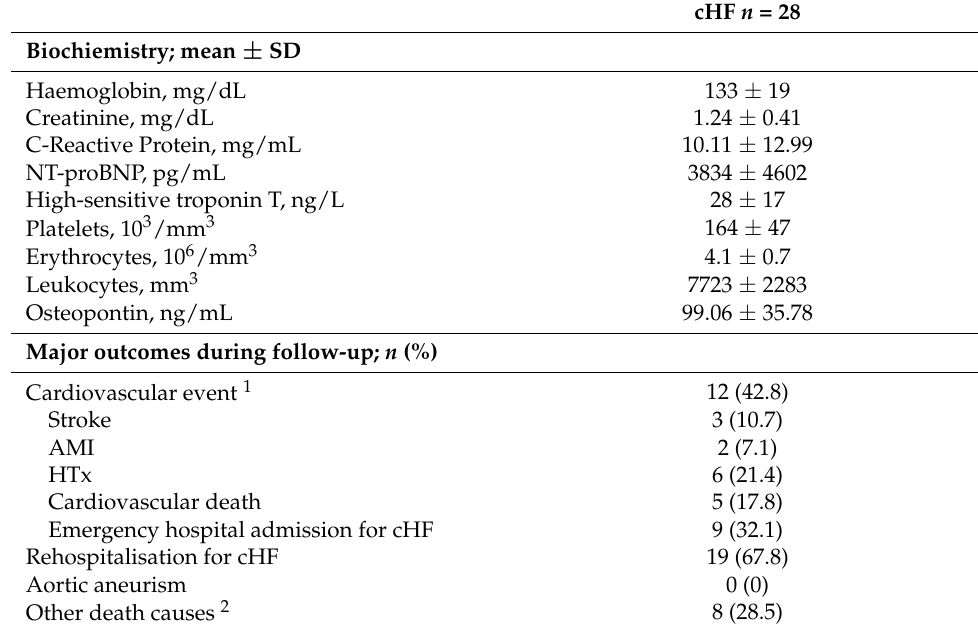
Table 5. Biochemical and clinical outcomes of cHF patients in the miRNA selection.